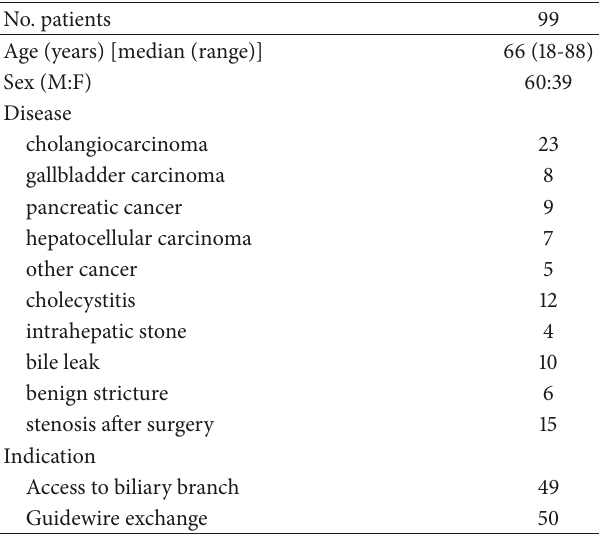
Table 2: Patient